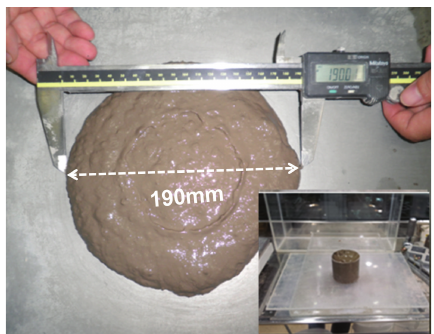
Figure 5: Slump flow assessment of the new filling